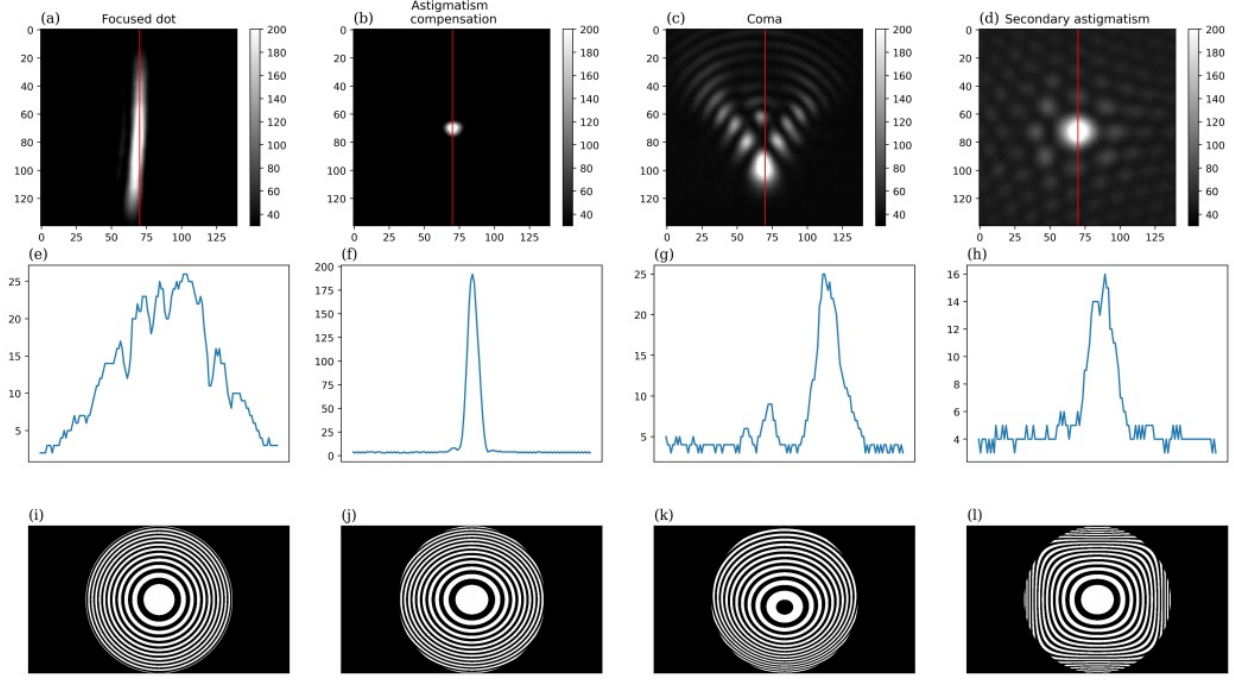
tion. Micromirror “0” reflects light to the side, and micromirror “1” reflects light into the camera/optical system.